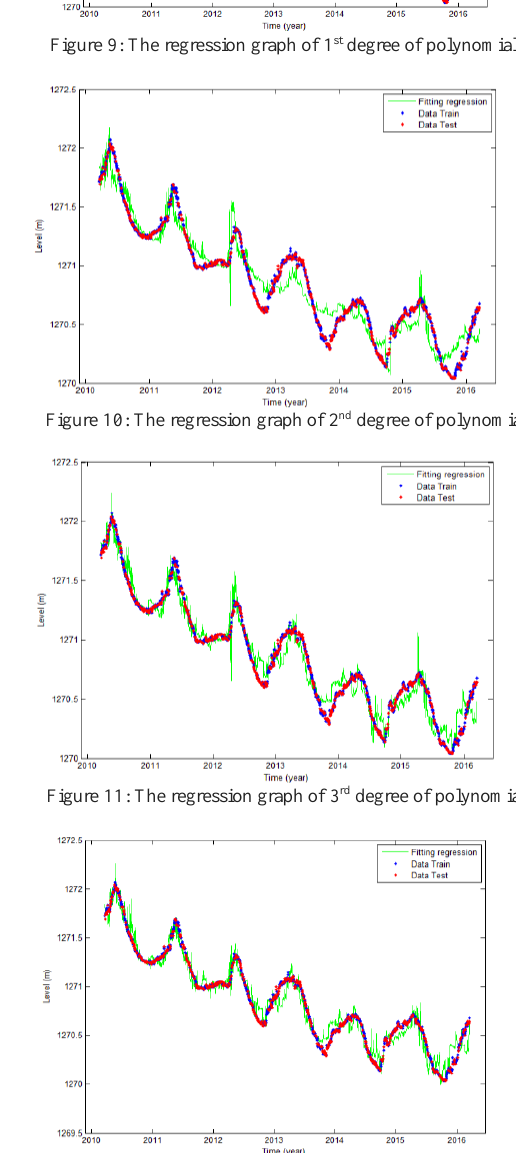
Figure 12: The regression graph of 4 th degree of